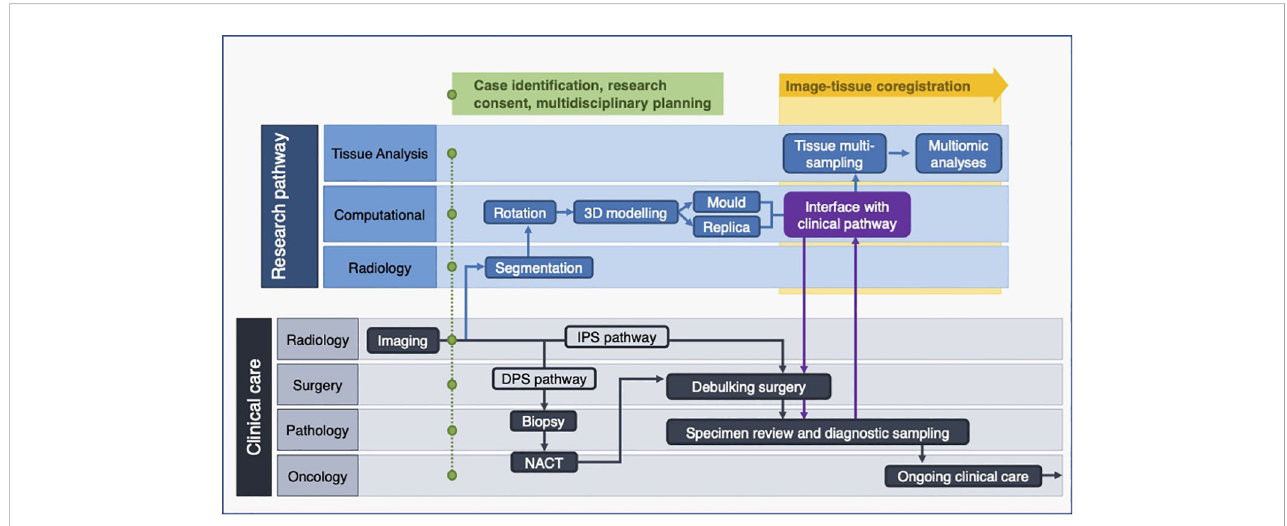
FIGURE 12 Multidisciplinary research pathway for malignant pelvic ovarian tumours. Interface with clinical pathway shown in purple. DPS, (delayed primary surgery); IPS, (immediate primary surgery); NACT, (neoadjuvant